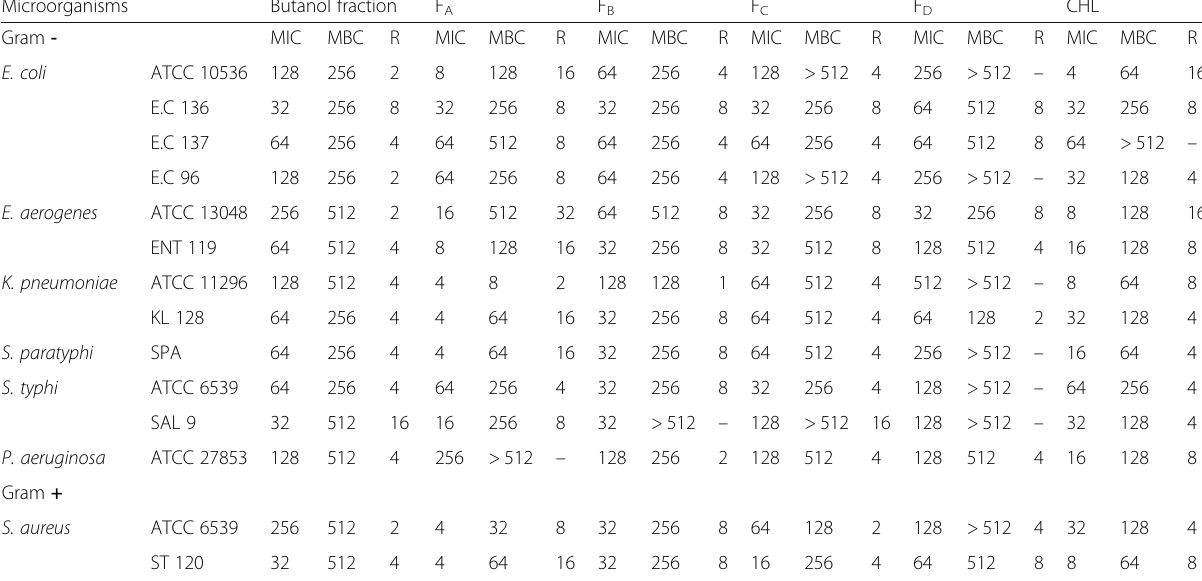
Table 3 Minimum Inhibitory Concentrations (MIC), Minimum Bactericidal Concentrations (MBC) and MBC/MIC ratios (R) of n-butanol fraction and sub- fractions from the methanol extract of E. chlorantha stem barks ( μ g/mL) Microorganisms Butanol fraction F A